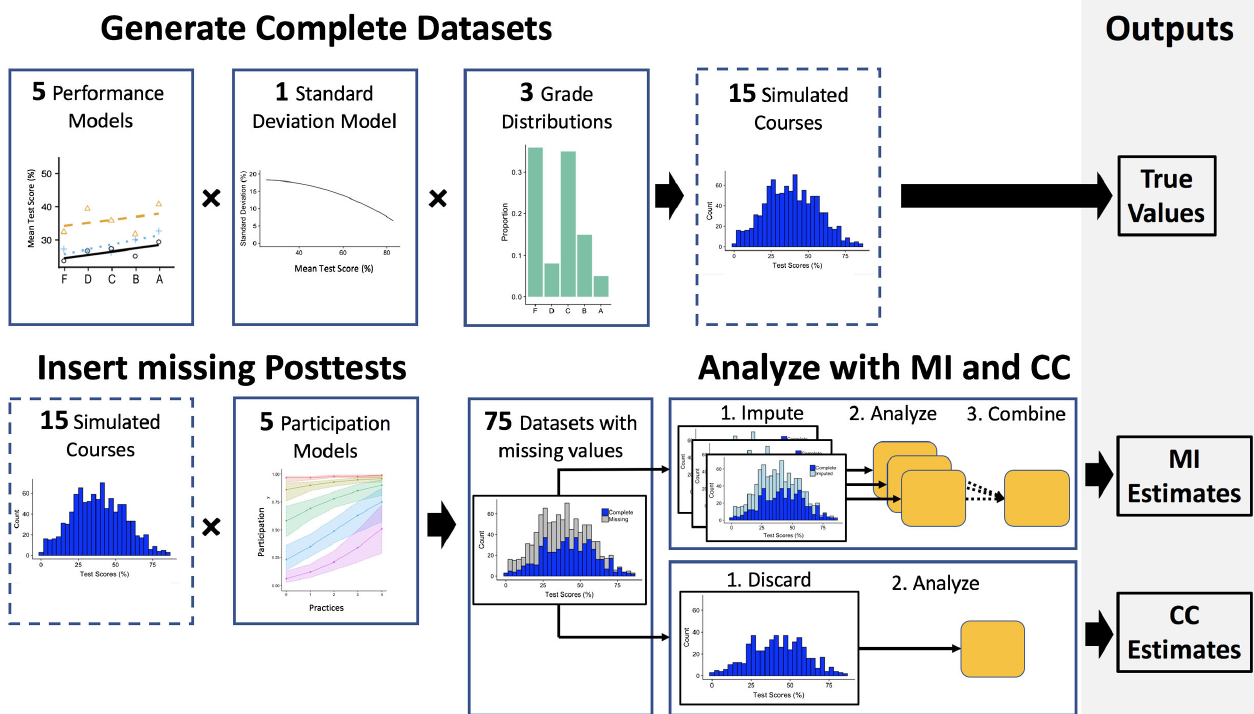
FIG. 5. Overview of data simulation and analysis methods. In the first stage, we used models of performance, standard deviation, and grade distributions to simulate courses. These simulated courses provided the true values for our analyses. In the second stage, we used participation models to create missing data by deleting post-test scores from the simulated course data. In the third stage, we analyzed the data sets with missing data using both multiple imputation (MI) and complete-case analysis (CC). This stage provided the MI and CC estimates. We used the three outputs (true values, MI estimates, and CC estimates) to investigate the bias introduced by MI and complete-case